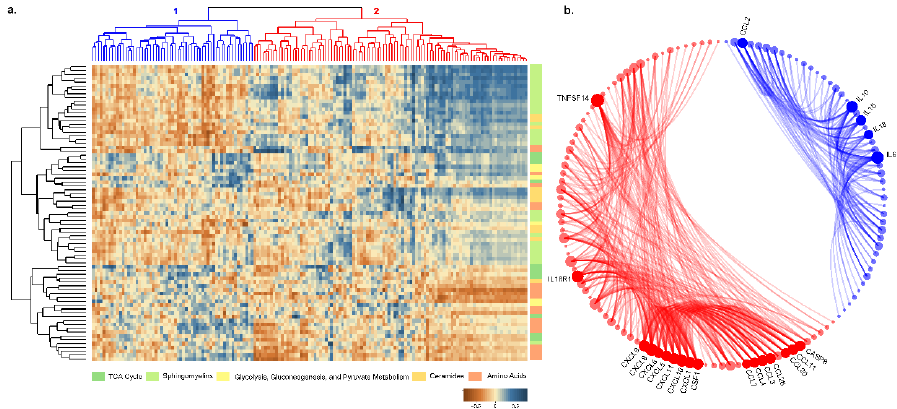
Figure 10. ( a ) Pearson correlation coefficient visualization and hierarchical clustering between metabolites and proteins. Metabolites belonging to various categories were plotted in rows and proteins in columns. ( b ) Protein–protein interaction results between two clusters of proteins from correlation clustering. Blue elements are cluster-1 proteins, and red elements are cluster-2 proteins. Bubble size is relative to the number of interactions, and each ribbon implies an interaction.